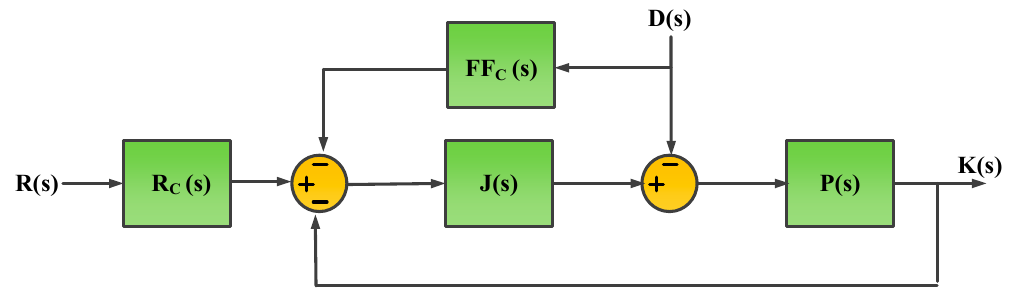
Figure 5. Three-degrees of freedom controller structure.